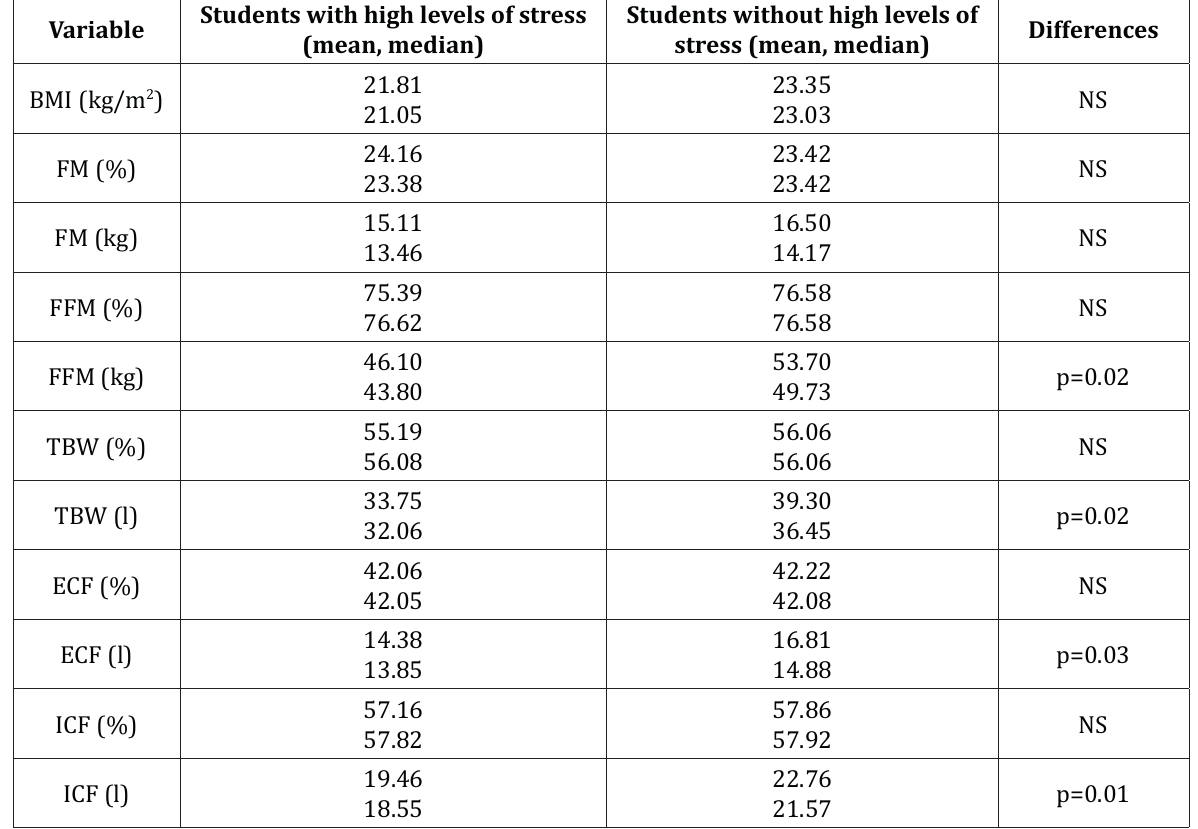
Table 2. Anthropometric measurements in examined population Students with high levels of stress Students without high levels of Variable (mean, median) stress (mean, median)